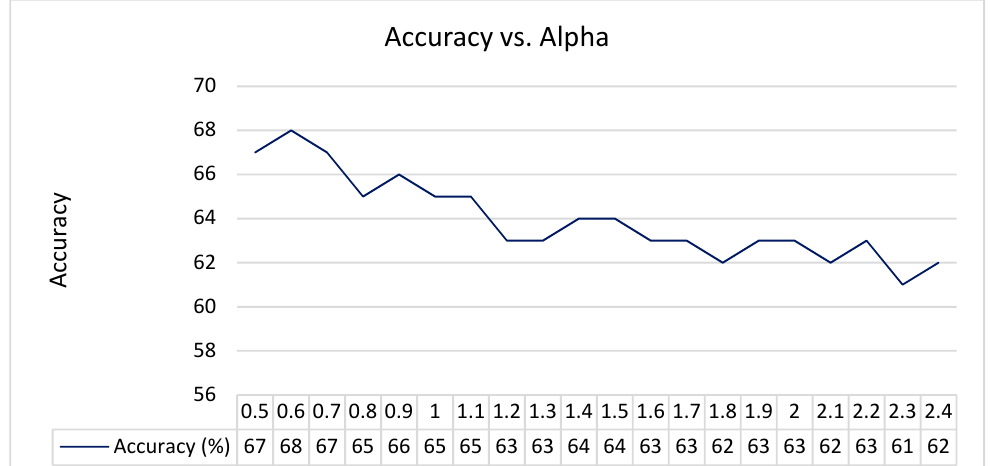
Figure 6. Variation of the accuracy of our mdel as a fucntion of 𝛼